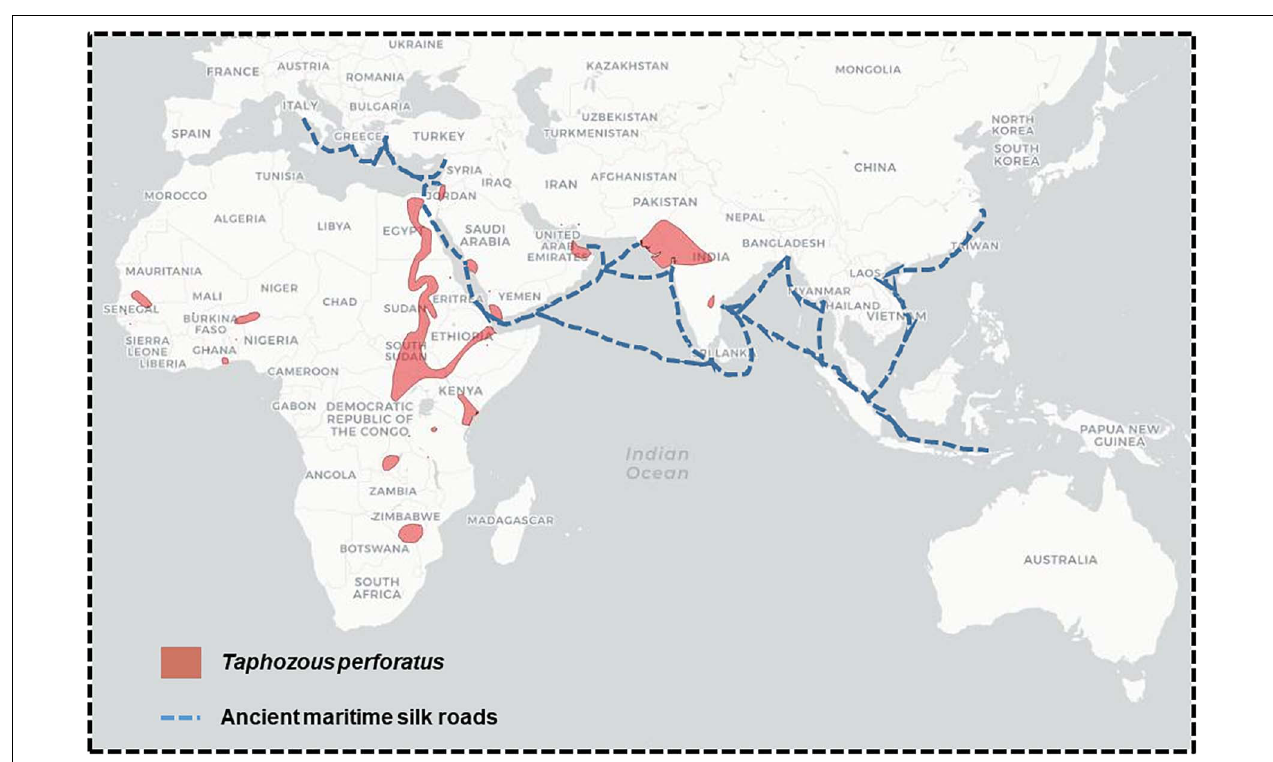
FIGURE 5 | Comparison of the distribution of Taphozous perforatus and the ancient silk